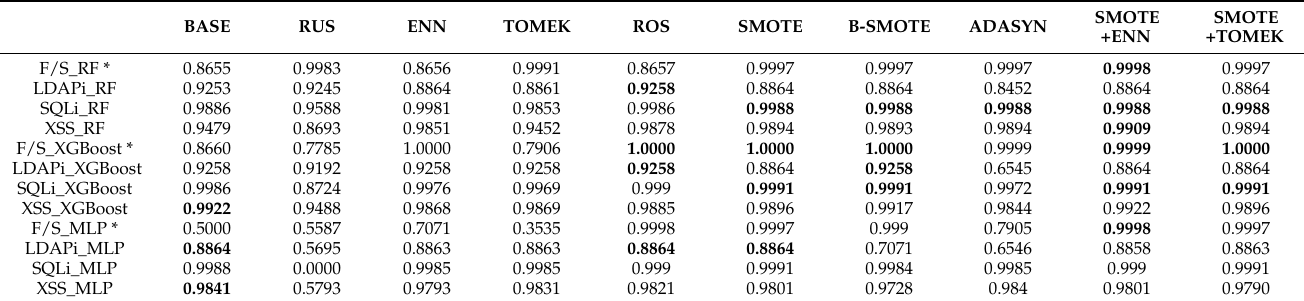
Table 8. Model performance results after sampling (dataset CSIC2012, G - mean ).